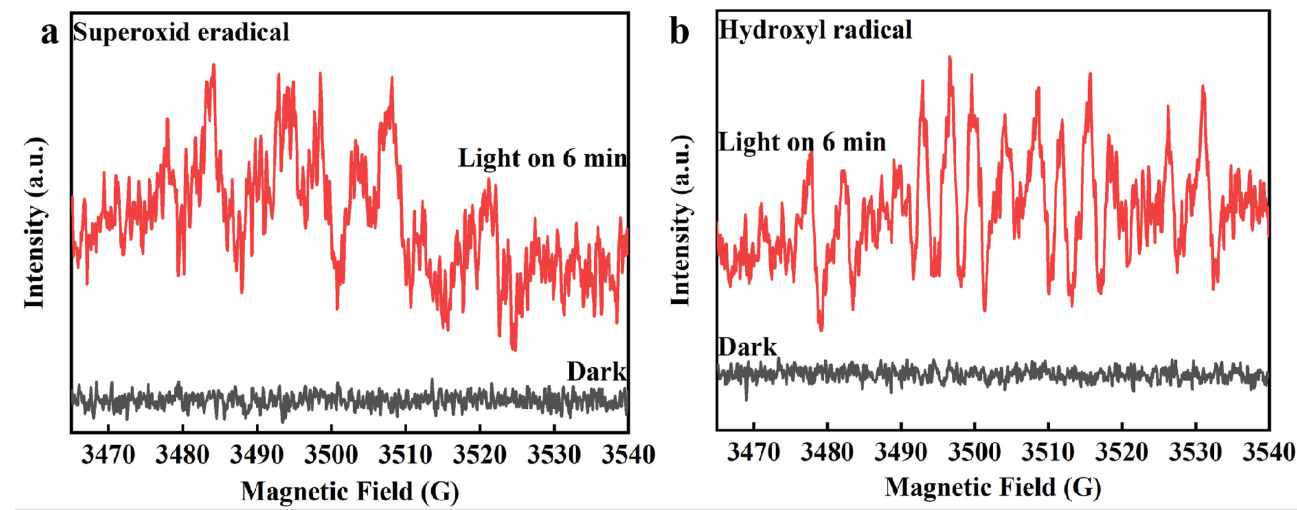
Figure 6. EPR spectra under dark and visible-light irradiation: ( a ) DMPO-O 2 - of ZMOCN-50 wt% and ( b ) DMPO-OH of ZMOCN-50 wt%.